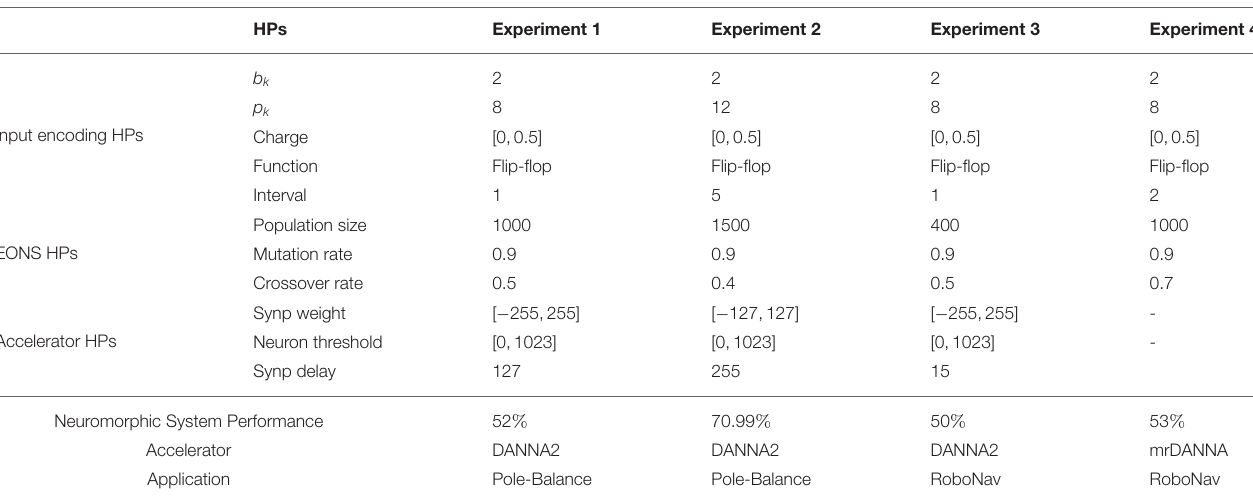
TABLE 5 | Sensitivity analysis for H-PABO single objective